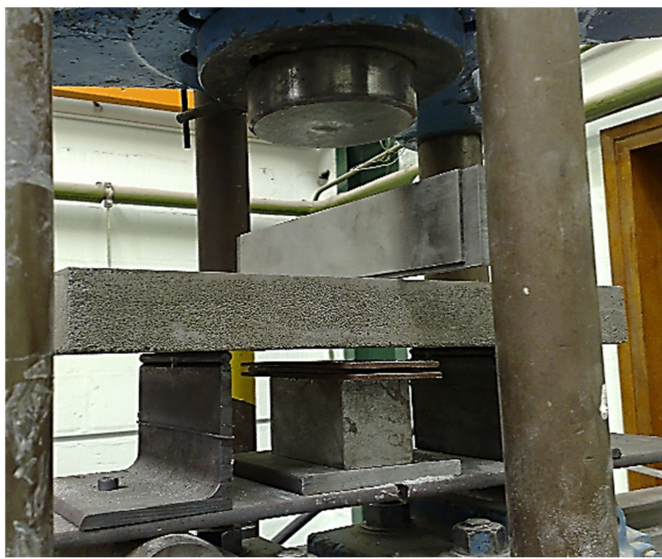
Figure 5. Setup for three-point bending test to determine the flexural strength of